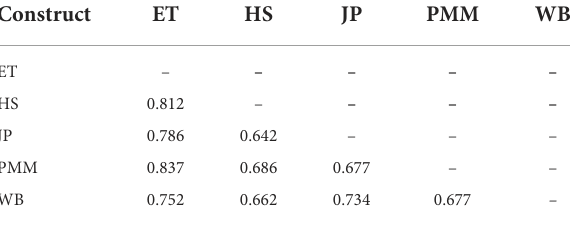
TABLE 3 Discriminant validity